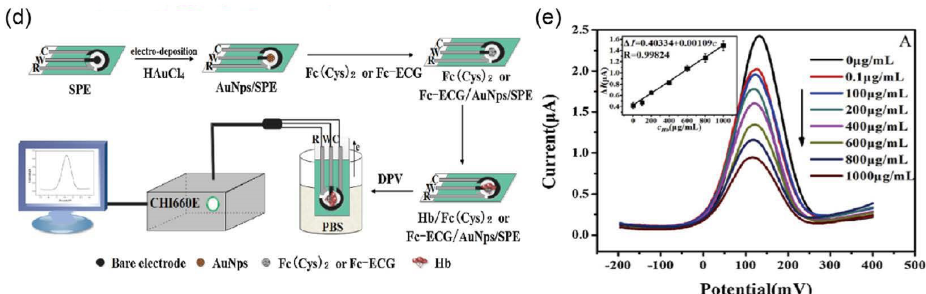
Figure 6. Selective detection of hemoglobin (Hb) in clinical samples ( a ) Proposed protocol of multi ‐ walled carbon nanotube (MWCNT) ‐ molecularly imprinted polymer (MIP) sensors for Hb detection. ( b ) The calibration curves reflect the response of the MWCNT ‐ MIP sensors. ( c ) Evaluation of the selectivity of the MWCNT ‐ MIP sensor toward myoglobin, human serum albumin, cytochrome C, and Hb. The potentiometric response showed no significant effects compared to Hb detection using the MWCNT ‐ MIP sensor (reprinted with permission from Ref. [39]; copyright 2017, Elsevier). ( d ) Illustration representing fabrication and test environment setup for Hb detection by differential pulse voltammetry (DPV). ( e ) DPV response of the Fc ‐ ECG/AuNPs/SPE electrochemical sensor against the concentration of Hb in the range of 0 to 1000 µg/mL. The inset shows a linear calibration curve for different concentrations of Hb. (Reprinted with permission from Ref. [40]; copyright 2019, Elsevier.)